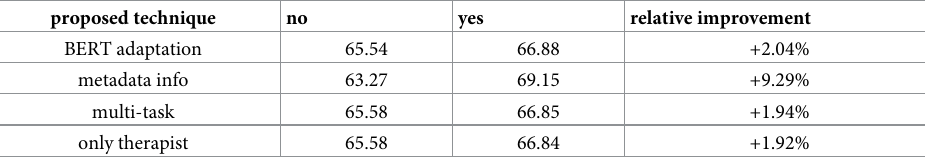
technique is ( yes ) or is not ( no )